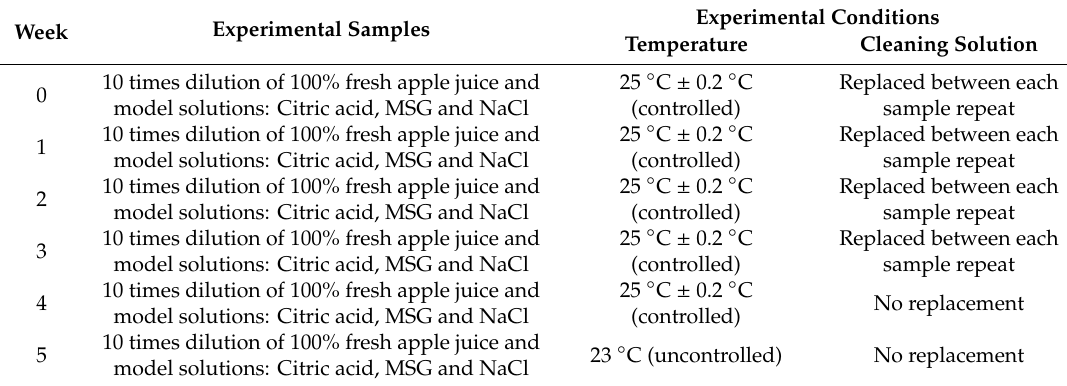
Table 1. Sample preparation and experimental conditions for drift correction measurements. Week Experimental Samples